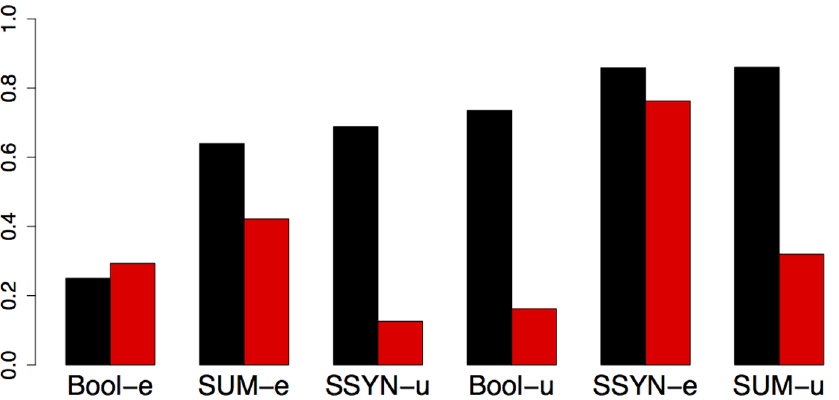
Figure 5. Comparison of ranking classifiers by AUC-PR using unweighted and weighted test data for query 29 from [18] . The AUC-PR for unweighted test data is depicted in black, whereas the AUC-PR for weighted test data is depicted in